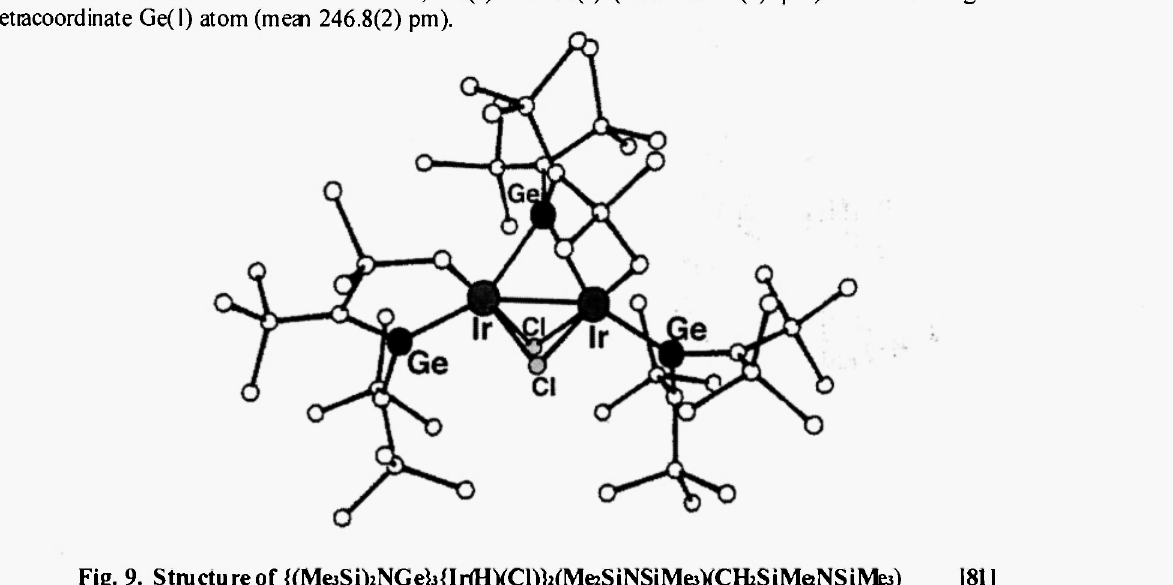
Fig. 9. Structure of {(MejSOzNGeMIi^XClMMezSiNSiMtoXCHzSiMeNSiMej)